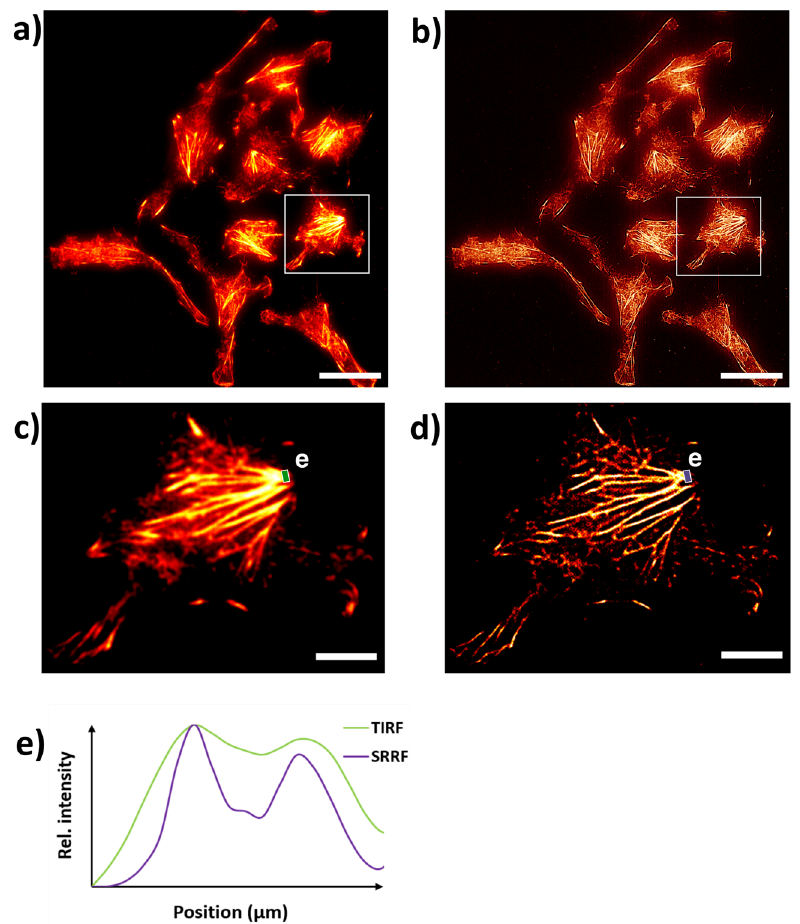
Fig. 6 c-TIRF and super-resolved image of actin in fi xed HeLa cells on a transparent waveguide. Here, a series of images were acquired using a water immersion objective lens (60×, 1.2 NA) on an inverted setup. a Shows an averaged c-TIRF image of actin in fi xed HeLa cells with the corresponding super- resolved SRRF reconstruction in ( b ). c , d Shows the zoomed-in region of the white boxes outlined in ( a , b ). Intensity pro fi les of the green and purple lines drawn across adjacent actin fi laments in ( c, d ) are plotted in ( e ) and show much clearer separation between actin fi bres in the SRRF image (purple lines) compared to c-TIRF (green lines). For the SRRF image, 500 frames were used and each of these frames was acquired with a 200 ms exposure time. The scale bar in ( a , b ) is 25 µ m and in ( c , d ) is 6 µ